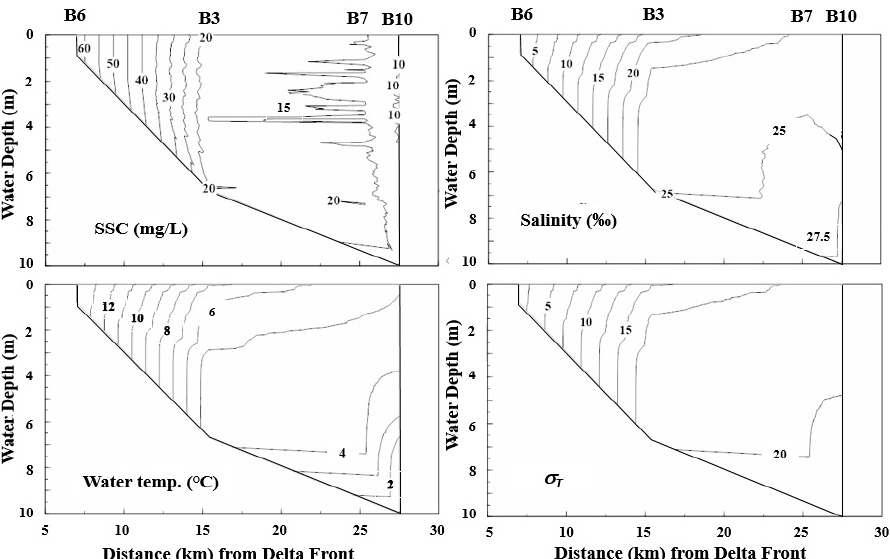
Figure 6. Traverse cross-sections of SSC, water temperature, salinity, and marine water density σ T by the coastal observation on the B1–B5 line on 6 September 2009 (Figure 1).